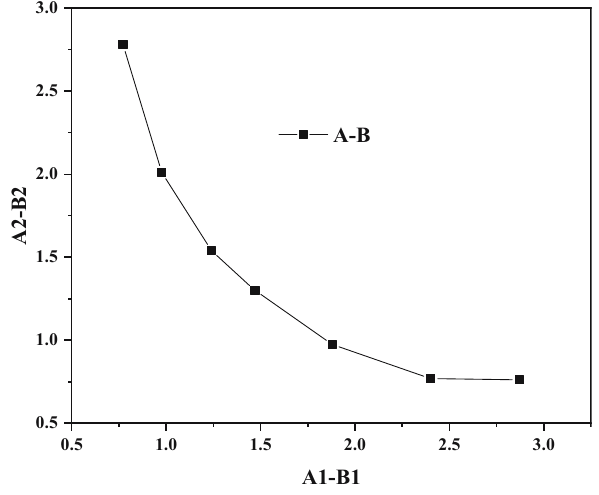
Figure 3: Multi - objective optimization